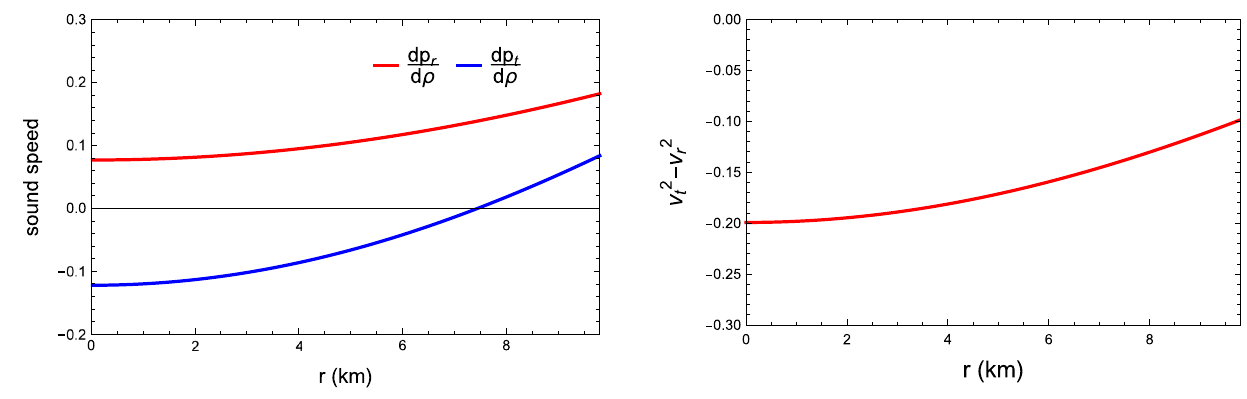
Fig. 8 Variation of sound velocities with the radial coordinate r Fig. 9 Differenceinsoundspeedsbelongingtotheregion ( − 1 , 0 ) with radial coordinate r